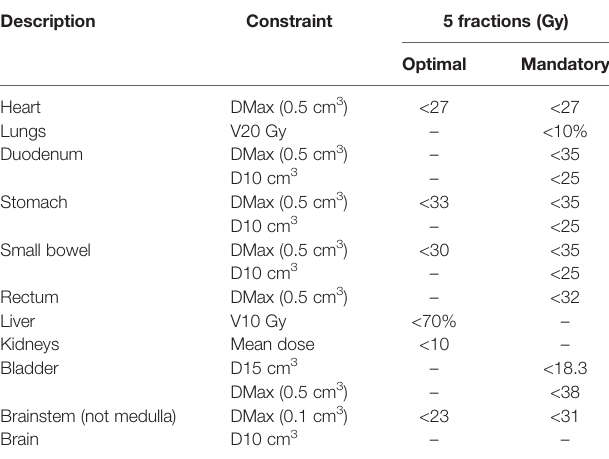
TABLE 4 | Normal tissue dose constraints for stereotactic